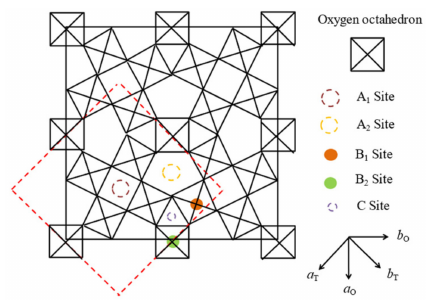
Figure 6. Projection of tungsten bronze structure on the c -plane. Tetragonal and orthorhombic unit cells are shown by dotted and solid lines, respectively